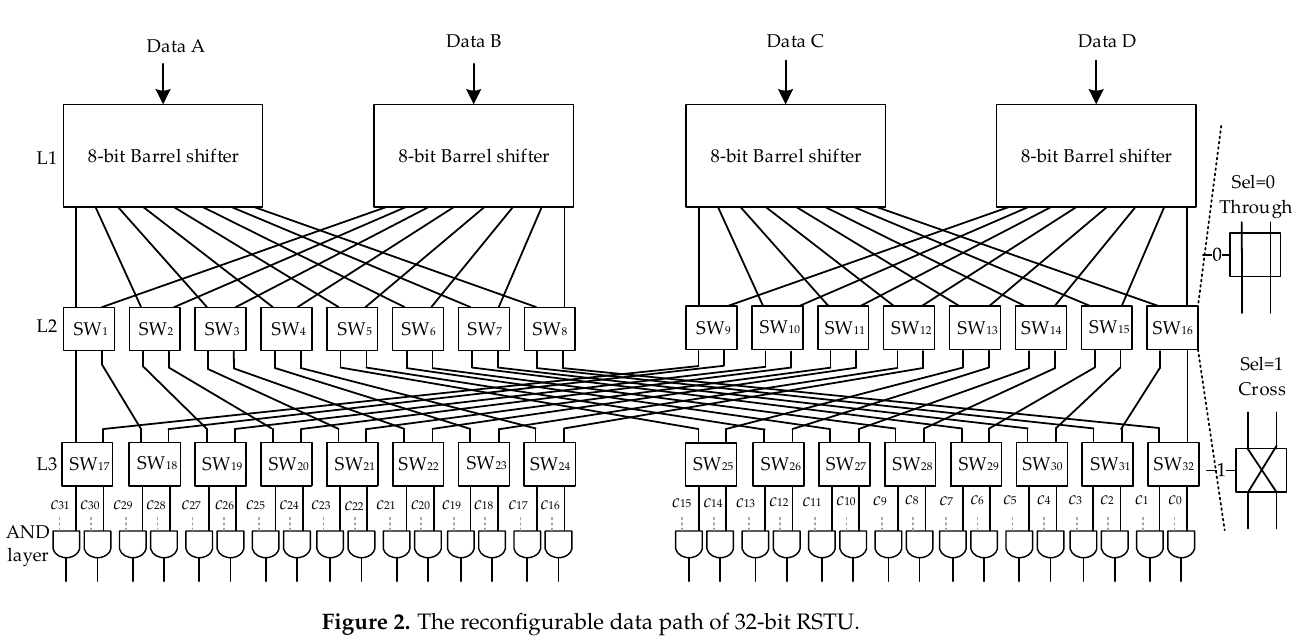
Figure 2. The reconfigurable data path of 32-bit RSTU.